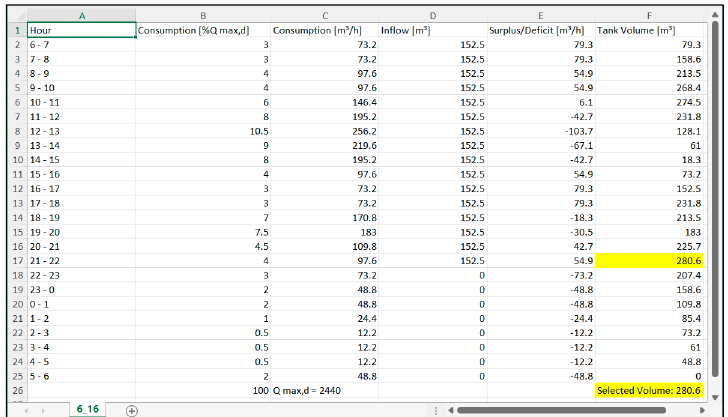
Figure 10. Screenshot of the obtained results (created MS excel file) for Variant II—single solution with minimum water tank volume.